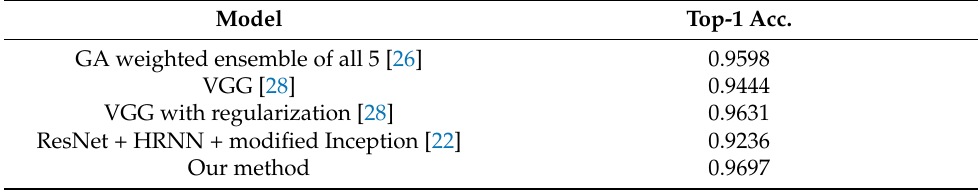
Table 4. Comparison with earlier methods from literature on AUC dataset.